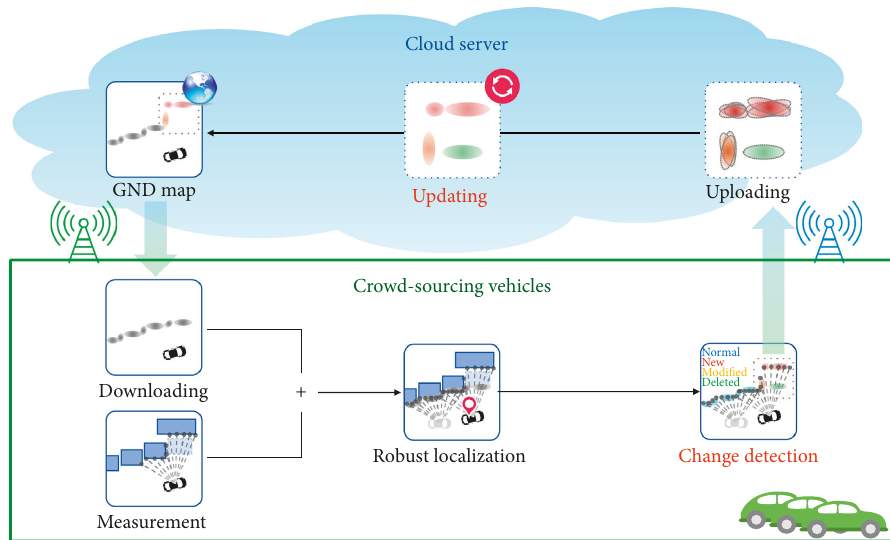
Figure 1: Overall framework of map update system based on crowd-sourced